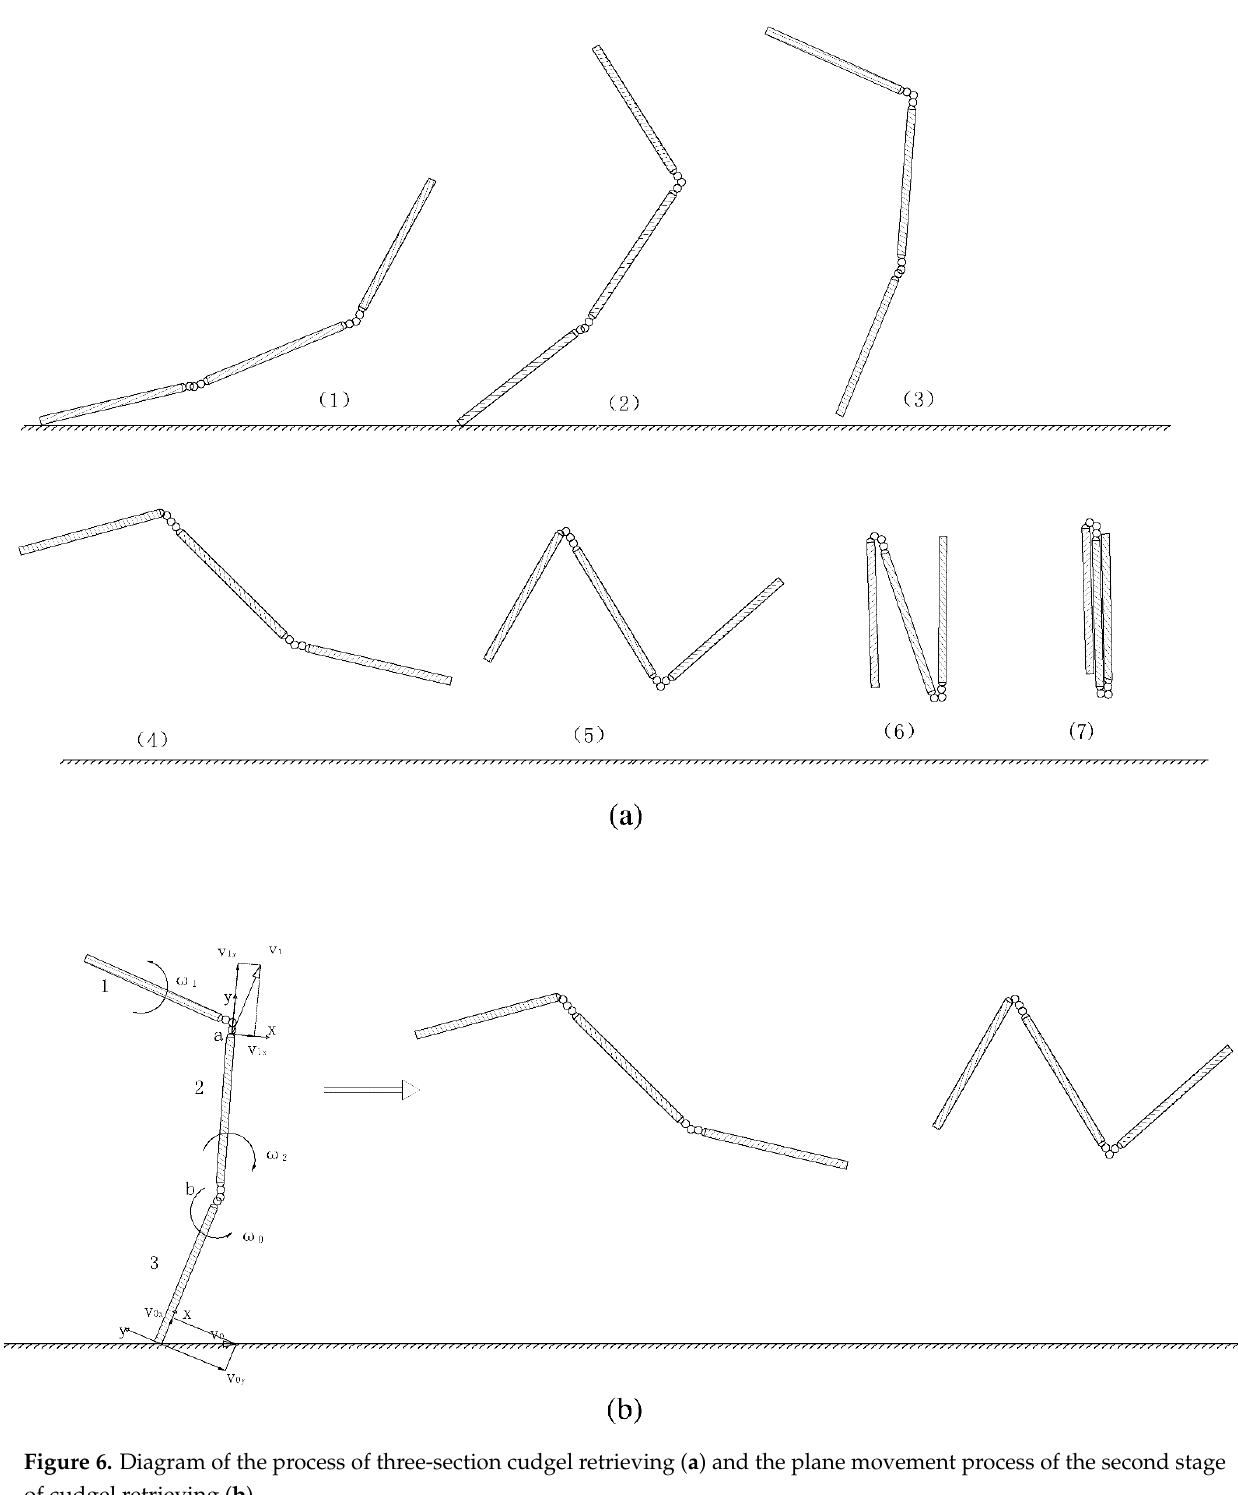
Figure 6. Diagram of the process of three-section cudgel retrieving ( a ) and the plane movement process of the second stage of cudgel retrieving ( b ).